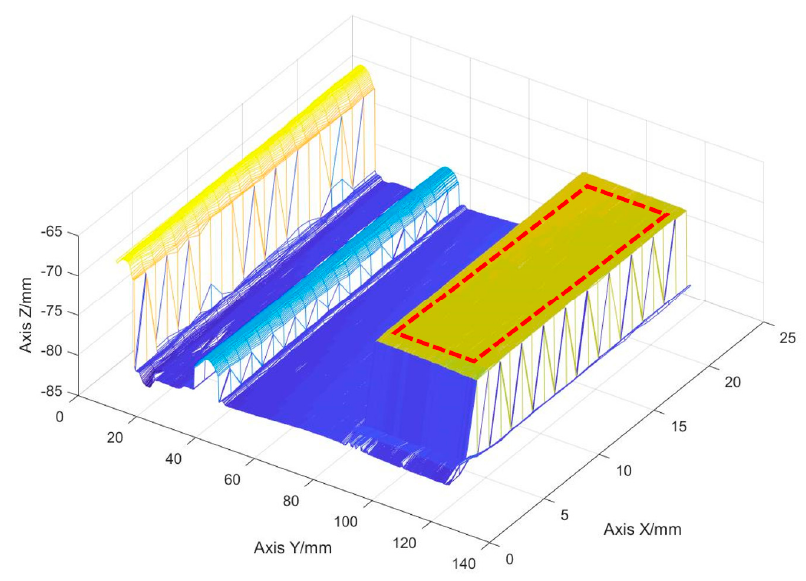
Figure 15. Measurement result of the deposit surface.